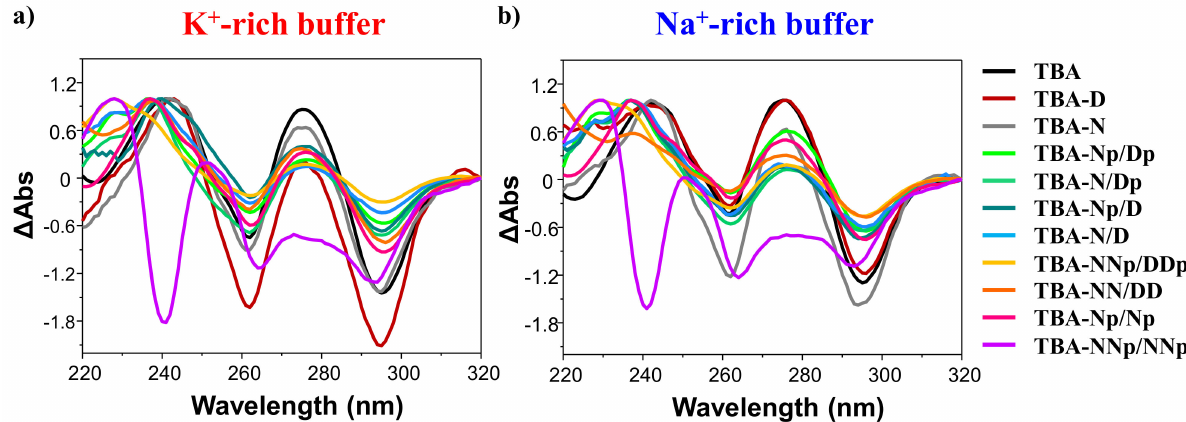
Figure 3. Representative normalized TDS profiles of the TBA analogues investigated at 2 µ M in both the K + -rich ( a ) and Na + -rich ( b ) buffer solutions, in comparison with unmodified TBA (black line). TDS profiles resulted from the subtraction of each UV spectrum registered at 15 ◦ C from the corresponding 90 ◦ C